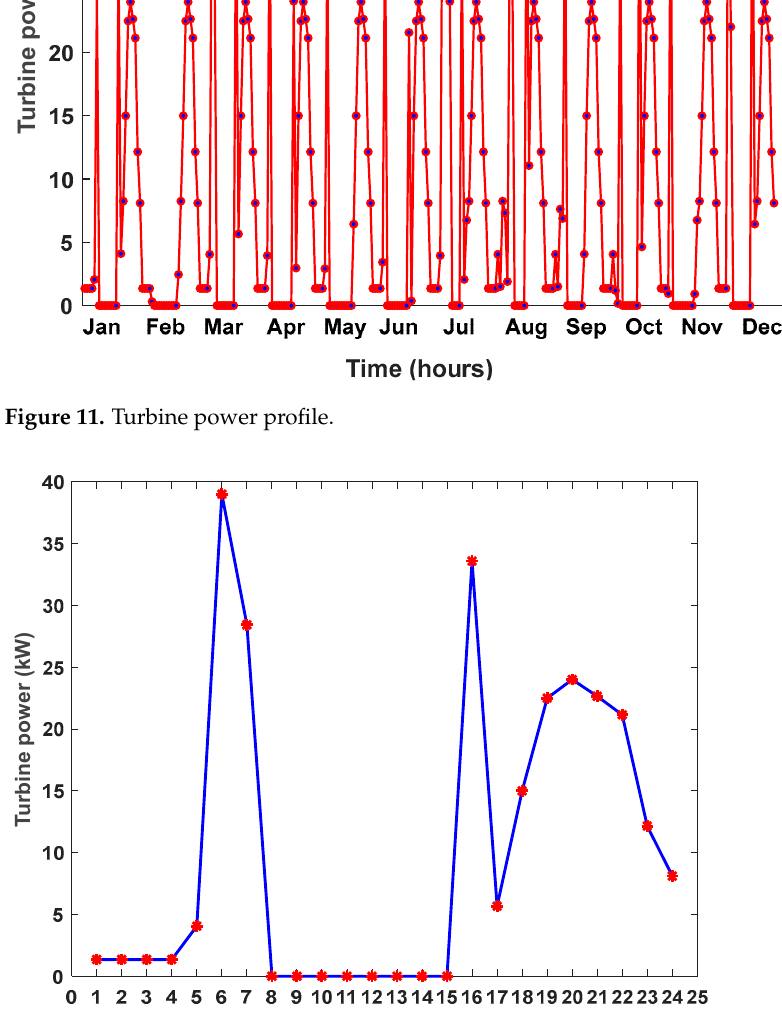
Figure 12. Turbine power profile for the month of March.